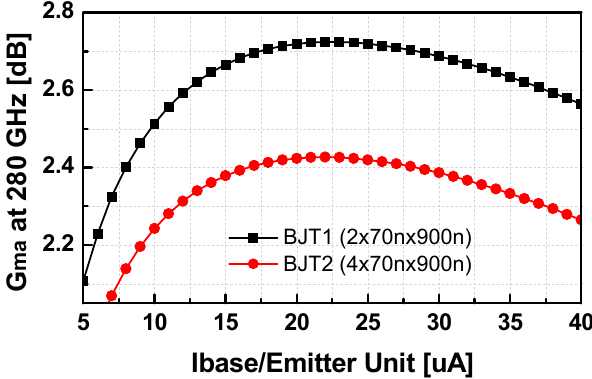
Figure 4. Simulated maximum available gain ( Gma ) at 280 GHz of HBTs versus the base bias current which is scaled with the emitter size of 2 × 70 nm × 900 nm as a unit).